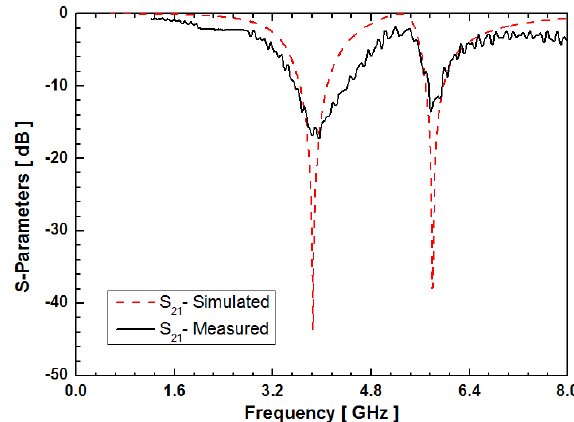
Fig. 8: Simulation and measured results of dual-band microstrip bandstop filter